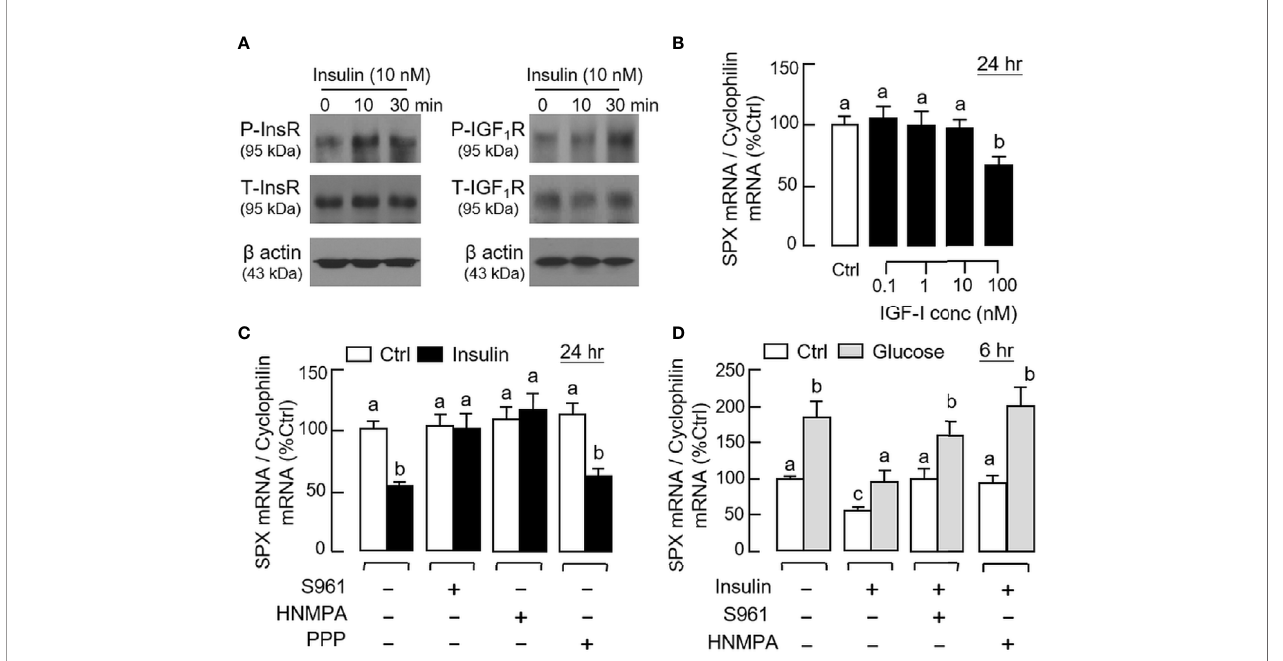
FIGURE 6 | Receptor speci fi city for insulin inhibition on SPX gene expression in mouse gastric mucosal cells. (A) Insulin activation of insulin receptor (InsR) and IGF-I receptor (IGF1R) expressed in gastric mucosal cells. Gastric mucosal cells were challenged with insulin (10 nM) up to 30 min and cell lysate was prepared for Western blot using the antibodies for the phosphorylated form ( “ P- ” form) and total protein ( “ T- ” form) of the respective receptors. Parallel blotting for b actin was also conducted to serve as the internal control. (B) Effect of increasing levels of IGF-I on SPX mRNA expression in gastric mucosal cells. (C) Effects of the insulin antagonist S961 (500 nM), InsR inhibitor HNMPA (10 µM) or IGF1R inactivator PPP (10 µM) on insulin inhibition (10 nM) of SPX gene expression in gastric mucosal cells. (D) Effects of S961 (500 nM) or HNMPA (10 µM) on insulin blockade (10 nM) of glucose (12 mg/ml)-induced SPX gene expression in gastric mucosal cells. In the studies for SPX gene expression, the duration of drug treatment was fi xed at 24 h. Data presented (mean ± SEM, N = 8) were analyzed by one-way ANOVA followed by Newman-Keuls test and the groups denoted by different letters represent a signi fi cant difference at p <